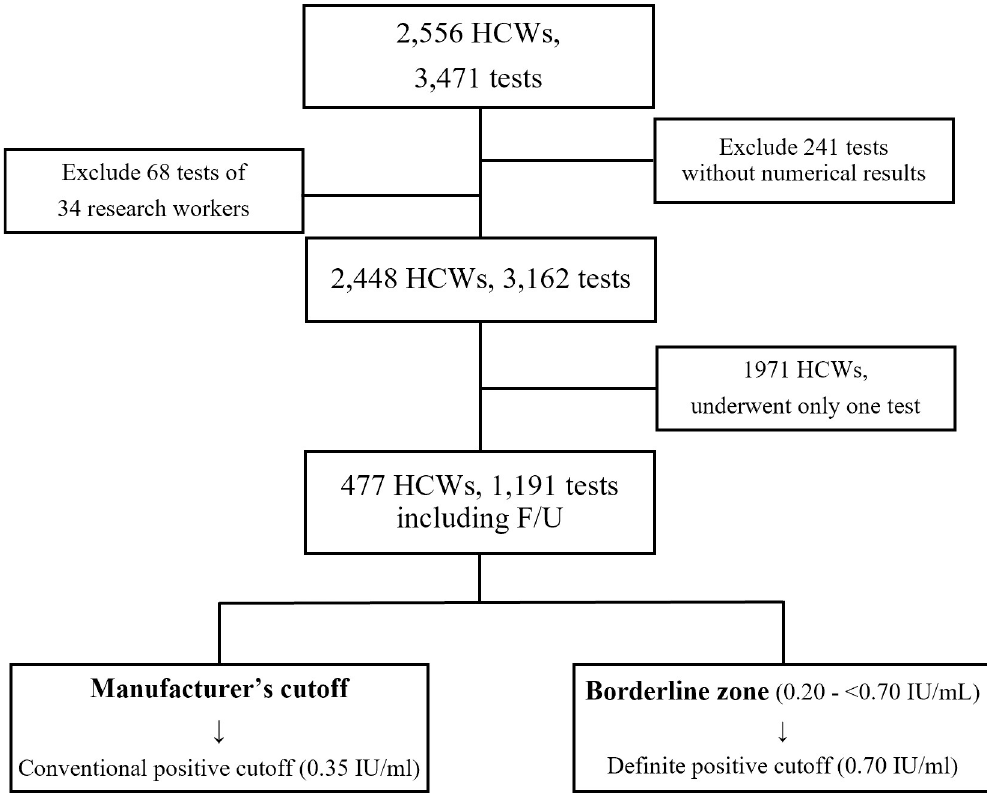
Fig 1. Flow chart of the study population. Abbreviations: HCW, healthcare worker; F/U, follow-up.